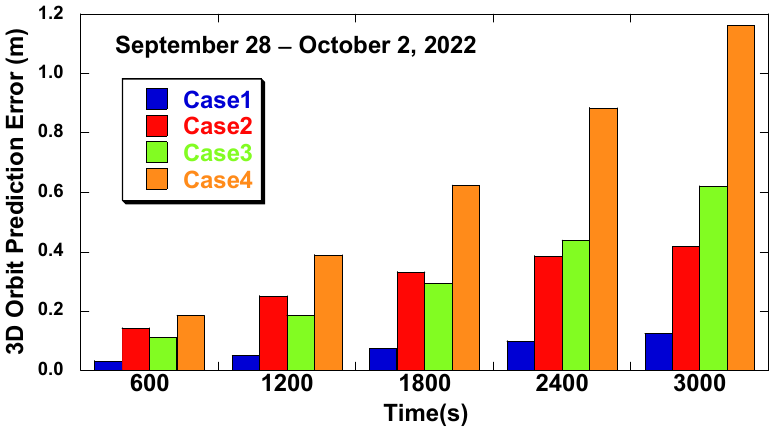
Figure 10. RTS orbit correction error at different prediction intervals (28 September–2 October 2022).